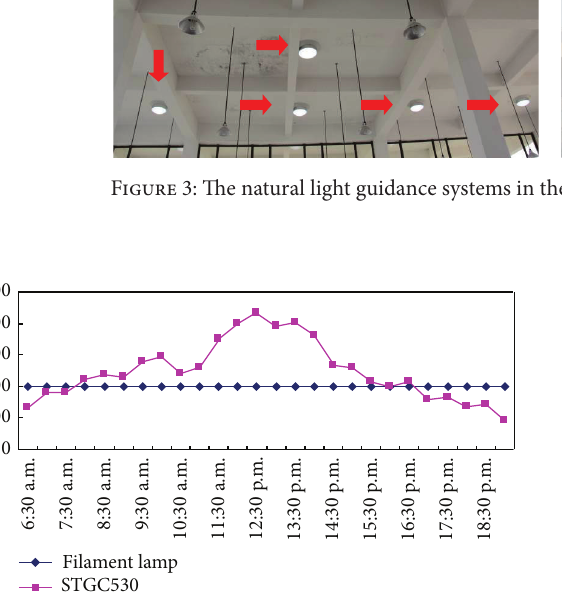
Figure 4: The illuminance effects comparison of light guidance system with electrical lighting.